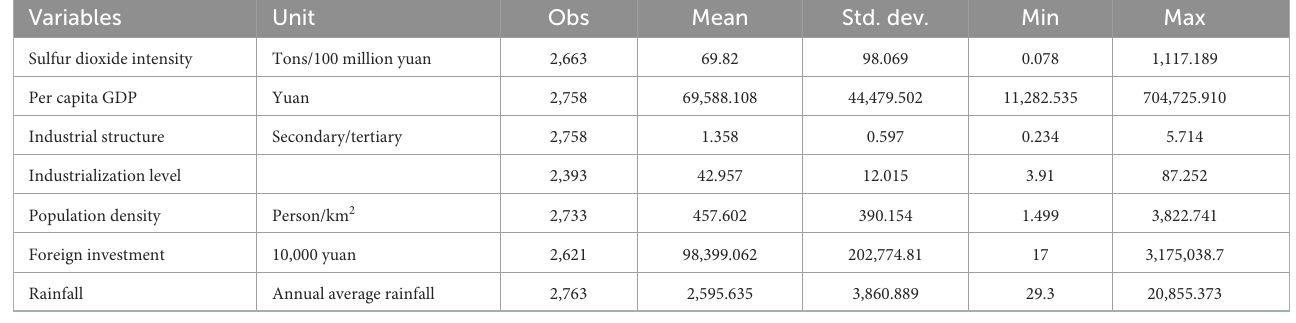
TABLE 2 Descriptive statistics.